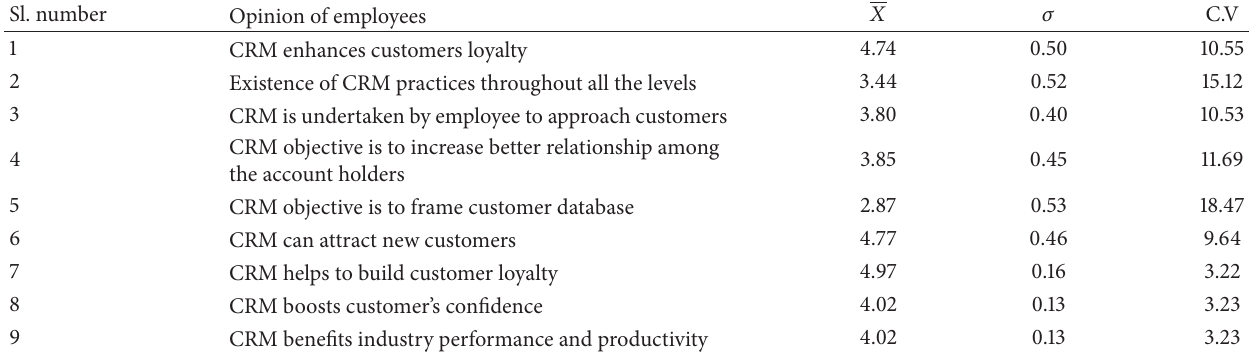
Table 13: Opinion about the CRM system in an integral part of the work in banks. Sl.